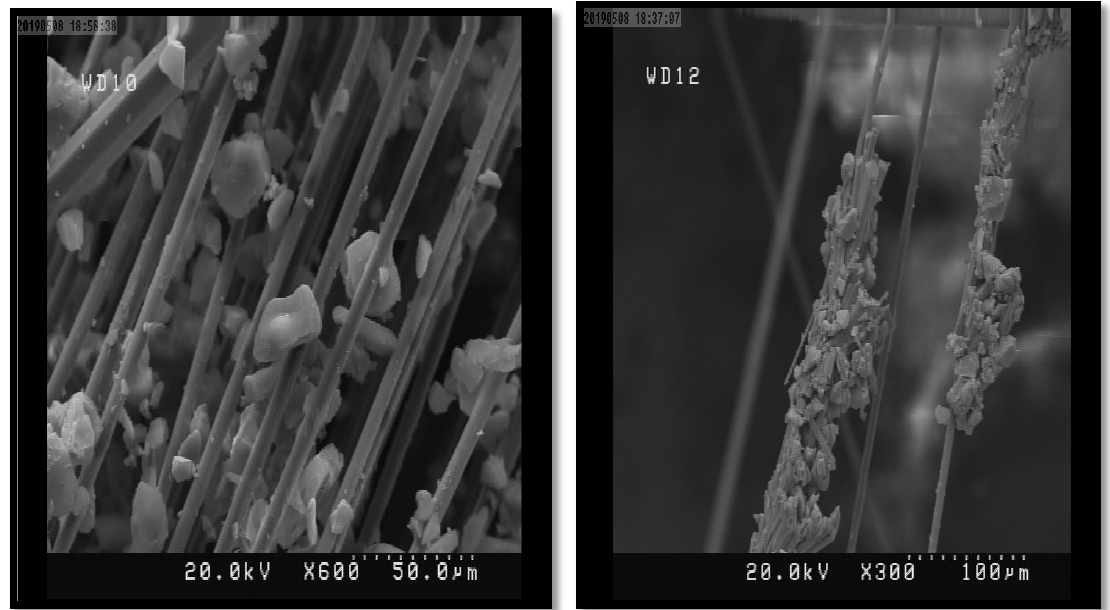
Fig.6: FE-SEM of coating carbon fibers with Al